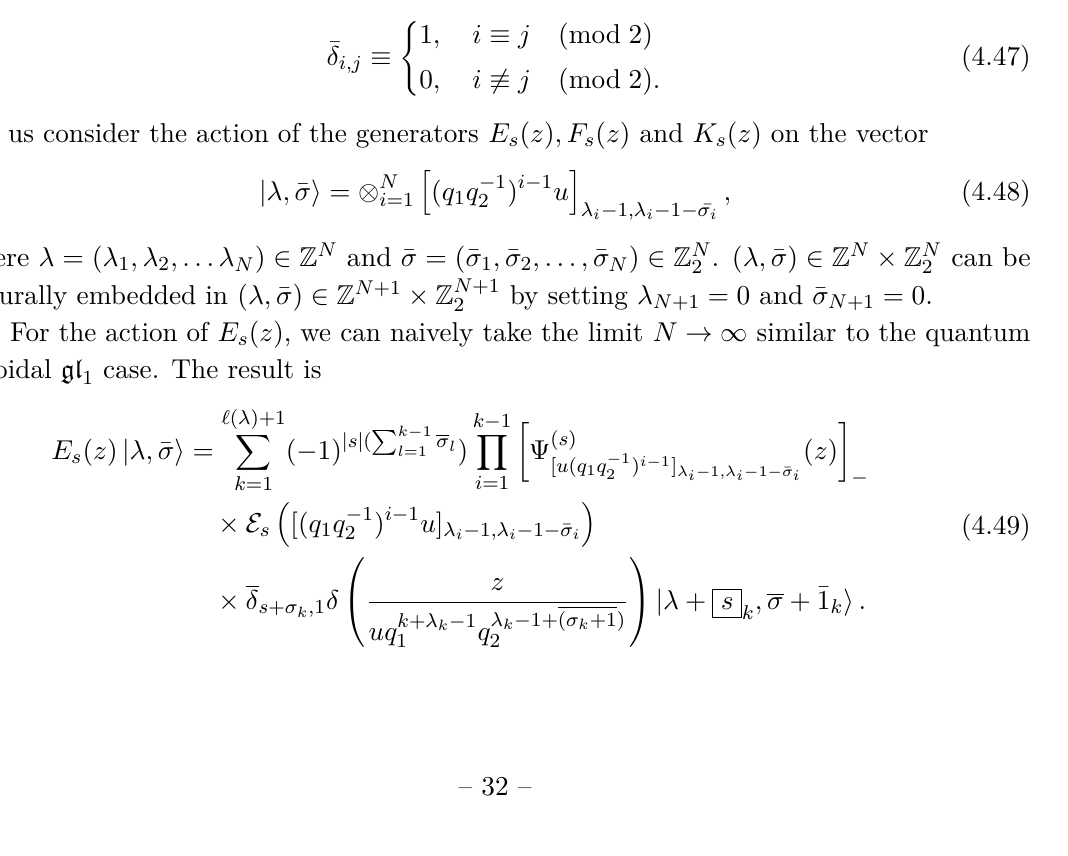
has λ blue and λ red ( λ, 0) ) i − 1 u ] − 1 1 q ( λ i , ¯ σ i ) 2